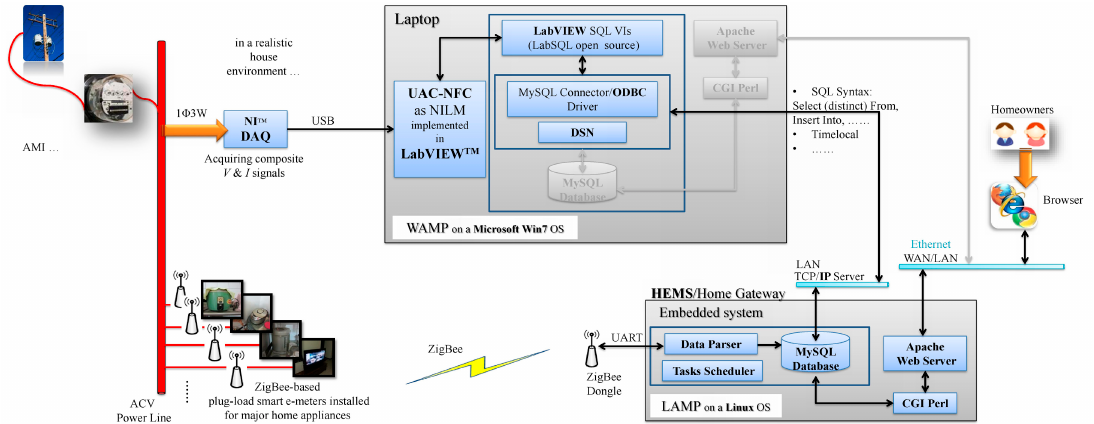
Figure 1. Block diagram of the centralized Internet of Things (IoT)-oriented smart Home Energy Management System (HEMS) with the proposed novel hybrid Unsupervised Automatic Clustering-integrated Neuro-Fuzzy Classification (UAC-NFC) model applied for Non-Intrusive Load Monitoring ( NILM ) .